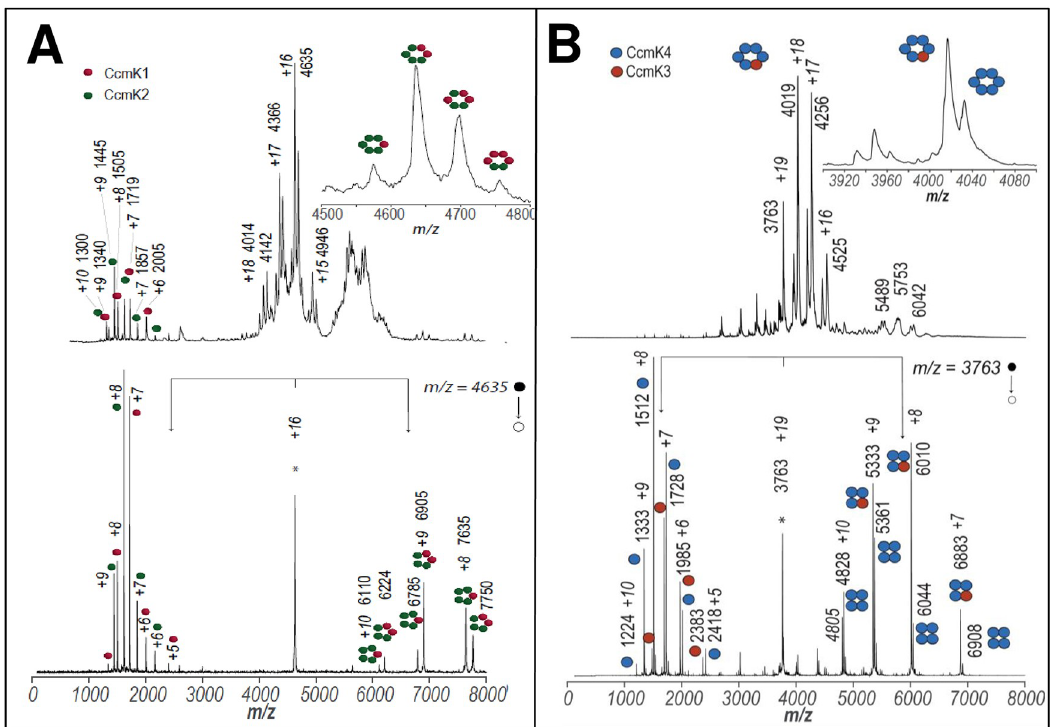
Fig 2. Hetero-hexamer characterization by native mass spectrometry. A , Spectra recorded on fractions purified from cells co- expressing CcmK1-His 4 together with CcmK2-FLAG; B , similarly, but from cells co-expressing His 4 -CcmK4 and CcmK3-FLAG. Positive-ion mode native ESI-MS spectra are presented on top panels. These spectra are dominated by signals from multiply charged ions of hexamers. Potential higher order assemblies were observed in combinations with CcmK2. Bottom panels present an example of MS-MS collisional activation data collected on hexamer precursor ions selected from top spectra (indicated with an asterisk). An asymmetric charge partitioning is noticed, hexamers dissociation resulting in two type of monomers and either pentameric species with CcmK1/K2 (left) or tetrameric species with CcmK3/K4 (right). Monomer masses permitted to attribute picks to either CcmK1 (red spheres), CcmK2 (green), CcmK3 (orange) or CcmK4 (violet). Species m/z values and charges are indicated for major peaks. Cartoons schematically illustrate the stoichiometries of detected protein complexes and subcomplexes. Molecular weights of neutral species estimated from data from different charge states are compiled in S1 Table. Please notice that tags were removed prior to spraying by treatments with TEV